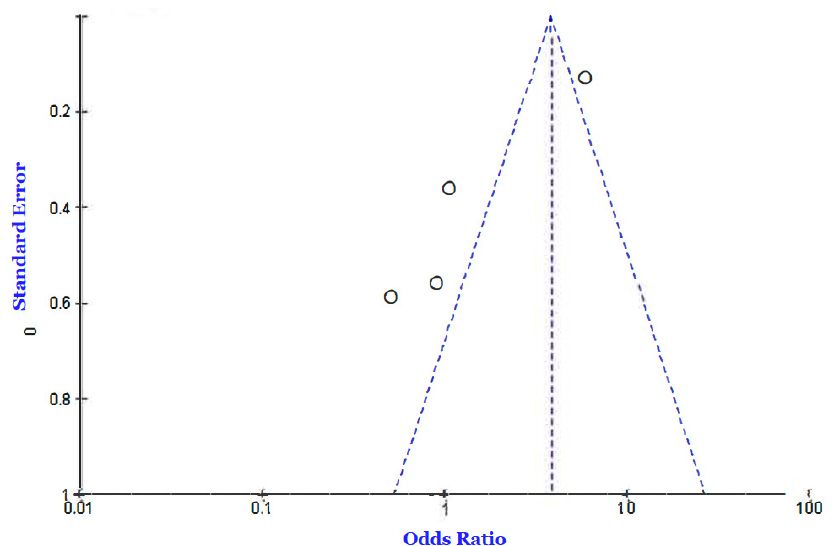
Figure 5. Funnel plot of the outcome of death in well-controlled vs. poorly controlled glycemic comparisons [3,29,30].